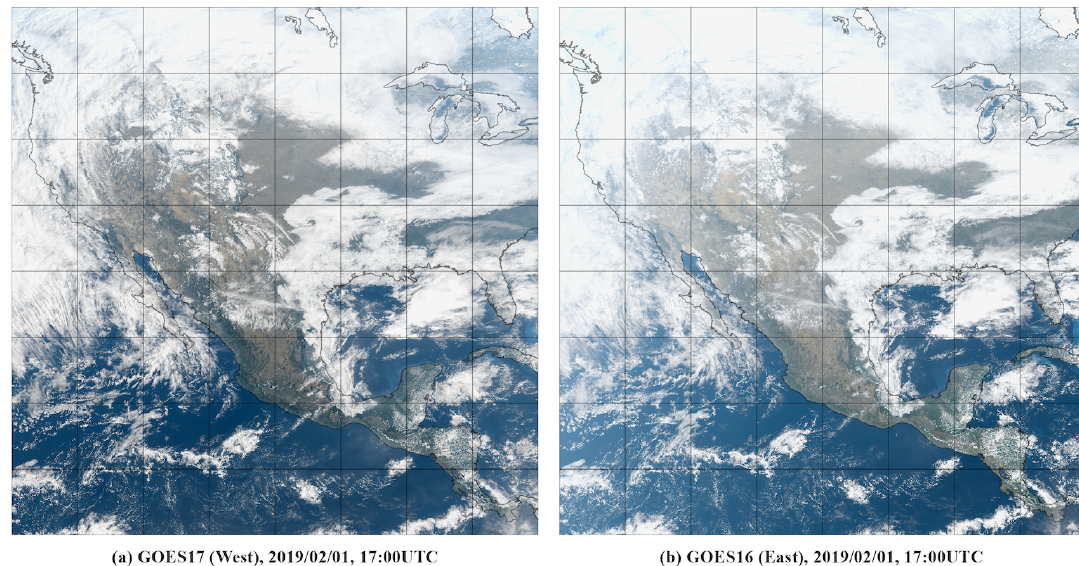
Figure 12. Concurrent TOA images of the Conterminous U.S. and Central America acquired by GOES16 and GOES17 at 17:00UTC on 1 February 2019. The pseudo true-color images are created based on TOA BRFs reprojected to the GeoNEX Common Grid, from Horizontal Tile 9 (126 ◦ W, left bound) to Tile 16 (78 ◦ W, right bound) and from Vertical Tile 1 (54 ◦ N, upper bound) to Tile 8 (6 ◦ N, lower bound). The longitude of the Sun is about 75 ◦ W at 17:00 UTC, outside the east boundary of the image. The subpoints of GOES16 and GOES17 can be found in Figure 3. The pseudo “green band” of the ABI instrument is generated from the red, the blue, and the near-infrared bands with linear weights of 0.483, 0.457, and 0.060, respectively. The thin gray lines indicate coastlines and the boundaries of the GeoNEX